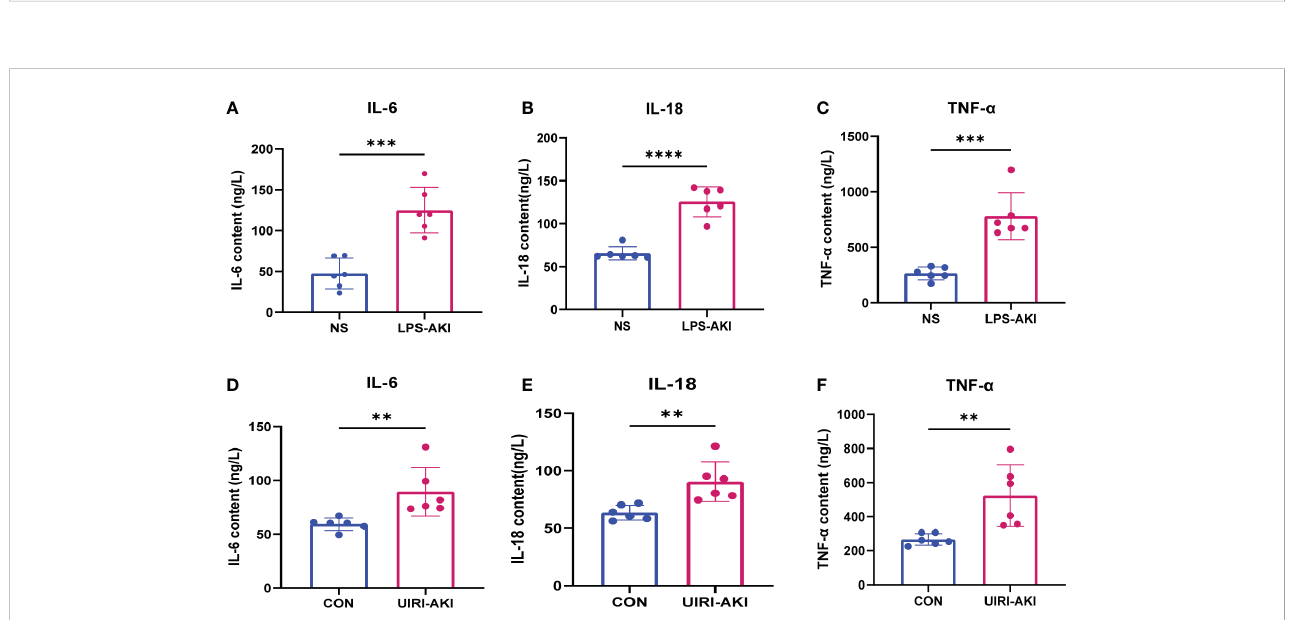
FIGURE 8 (A – F) ELISA analysis of IL-6, IL-18, TNF- a levels in UIRI-AKI and LPS-induced AKI models. Analyze the data using Student ’ s t-test. **p < 0.01, ***p < 0.001, ****p <